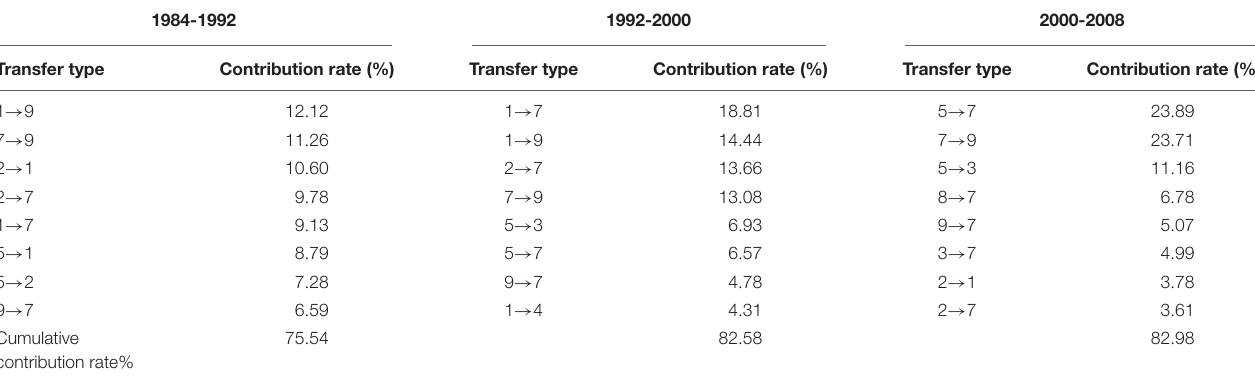
FIGURE 7 | Retention rate of main landscapes on Yancheng coast. TABLE 3 | The dominant transfer process and its contribution